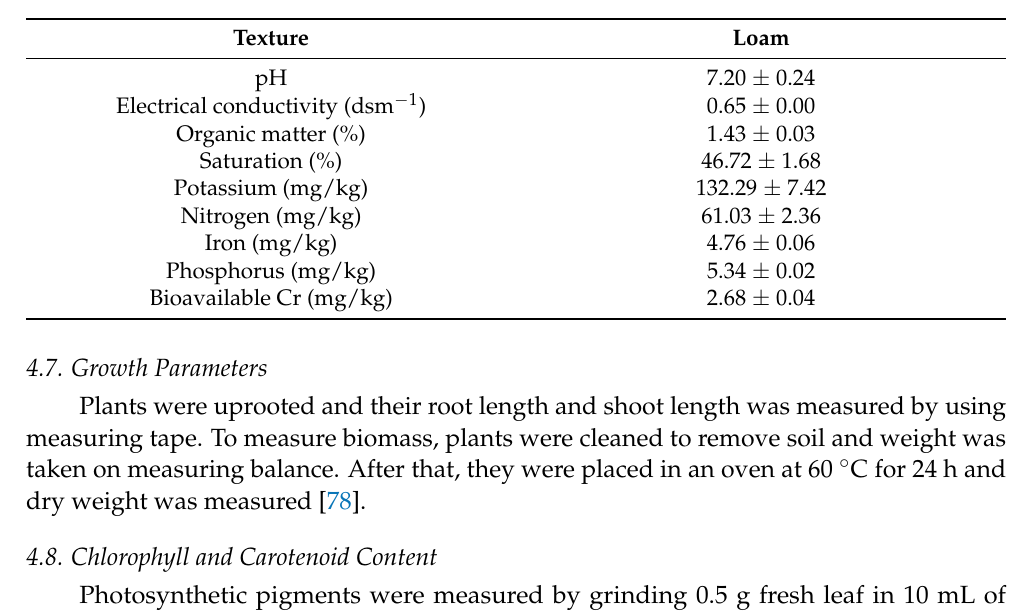
Table 7. Physicochemical analysis of soil used in the